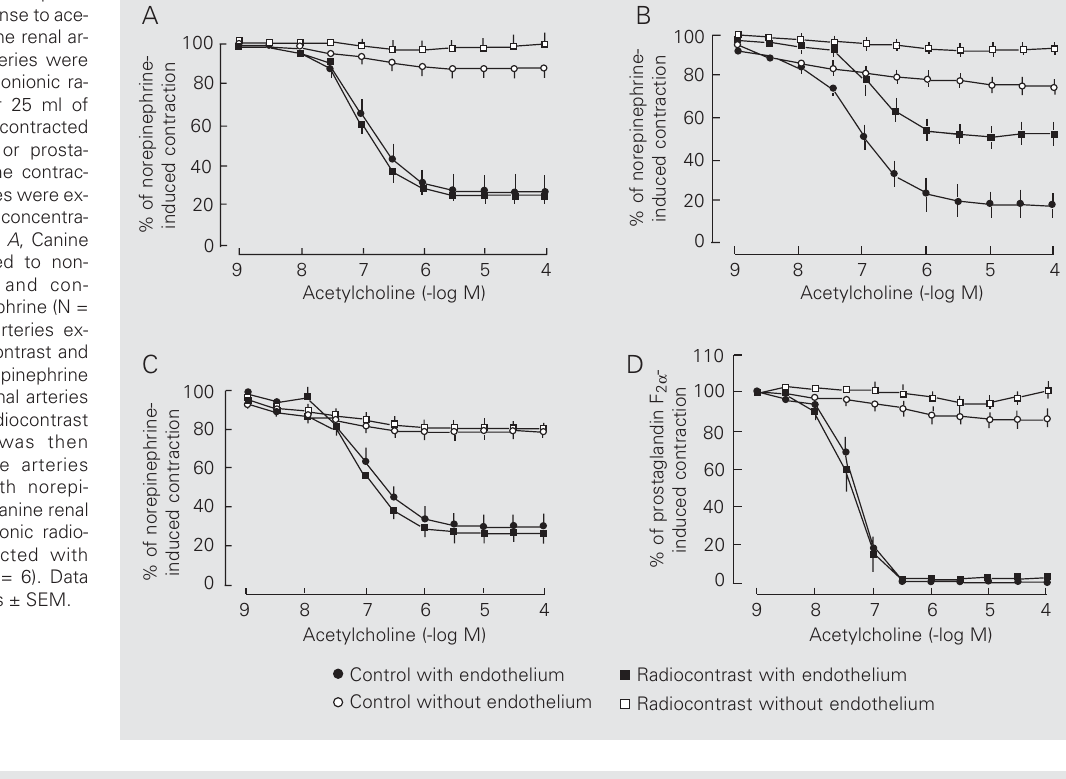
Table 1. Inhibition (-log M) of control and treated renal artery segments with and without endothelium.